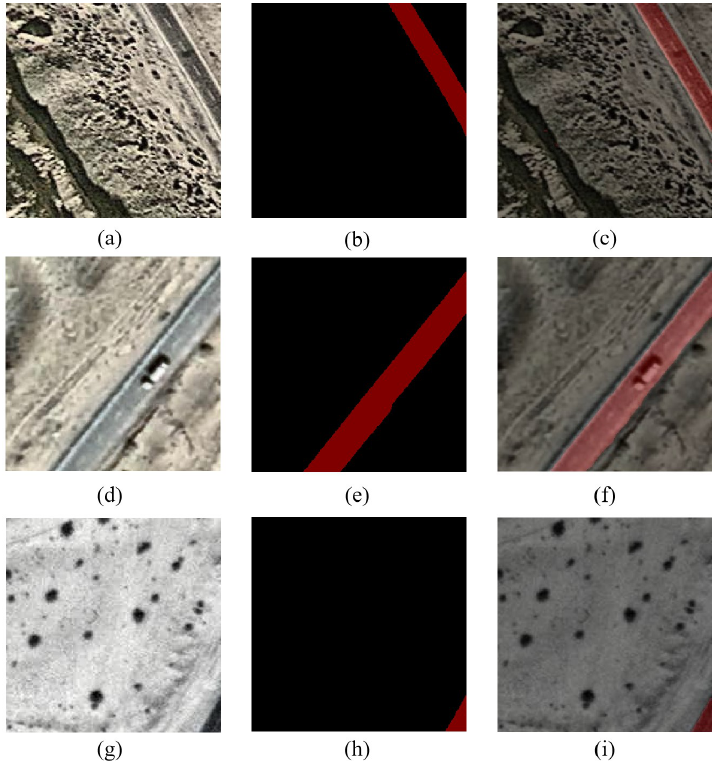
Figure 7. ( a , d , g ) are the original unprocessed images; ( b , e , h ) are the labels of RDCME; ( c , f , i ) are the predicted results.